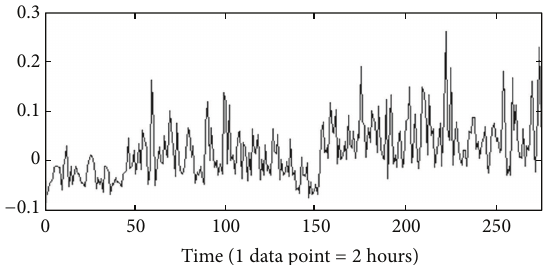
Figure 18: The first main projected vector of test bearing based on LTSA method.